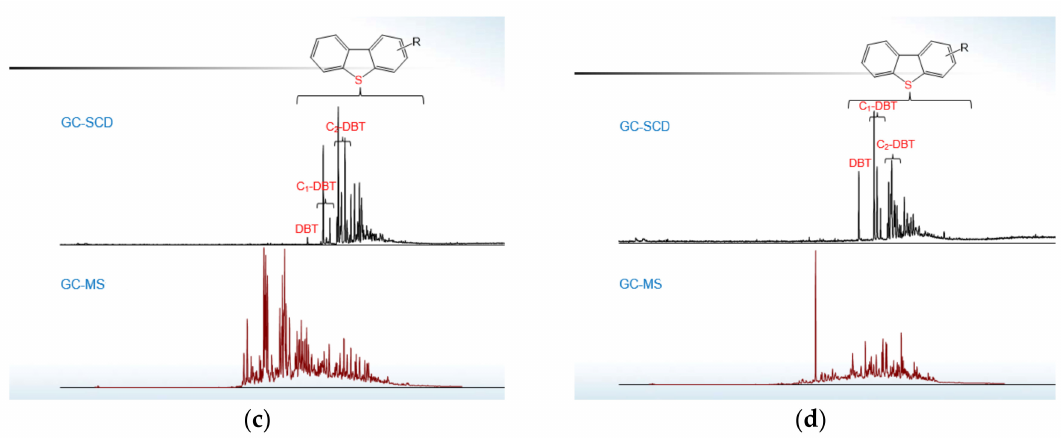
Figure 2. The GC-SCD and GC-MS spectra of thiophene sulfur: ( a ) WLT, ( b ) HCT, ( c ) QZT, and ( d ) HLT. The FT-ICR MS distribution spectra of thiophene sulfur in WLT, HCT, QZT, and HLT are shown in Figure 3. The horizontal axis represents the number of carbon atoms, and the vertical axis represents the degree of unsaturation. The size of the dot represents the relative abundance of the substance. It can be seen that thiophene sulfur in the transformer oil is mainly in the form of benzothiophene with unsaturation of 6, while dibenzothiophene with unsaturation of 9 as well as their homologues.